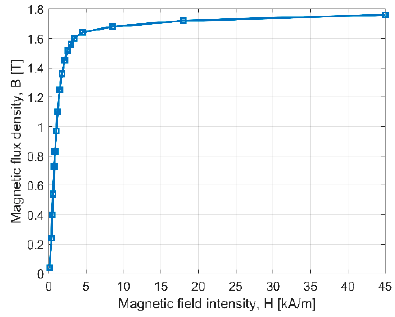
Figure 2. Measured B(H) curve of the steel S355J2H.